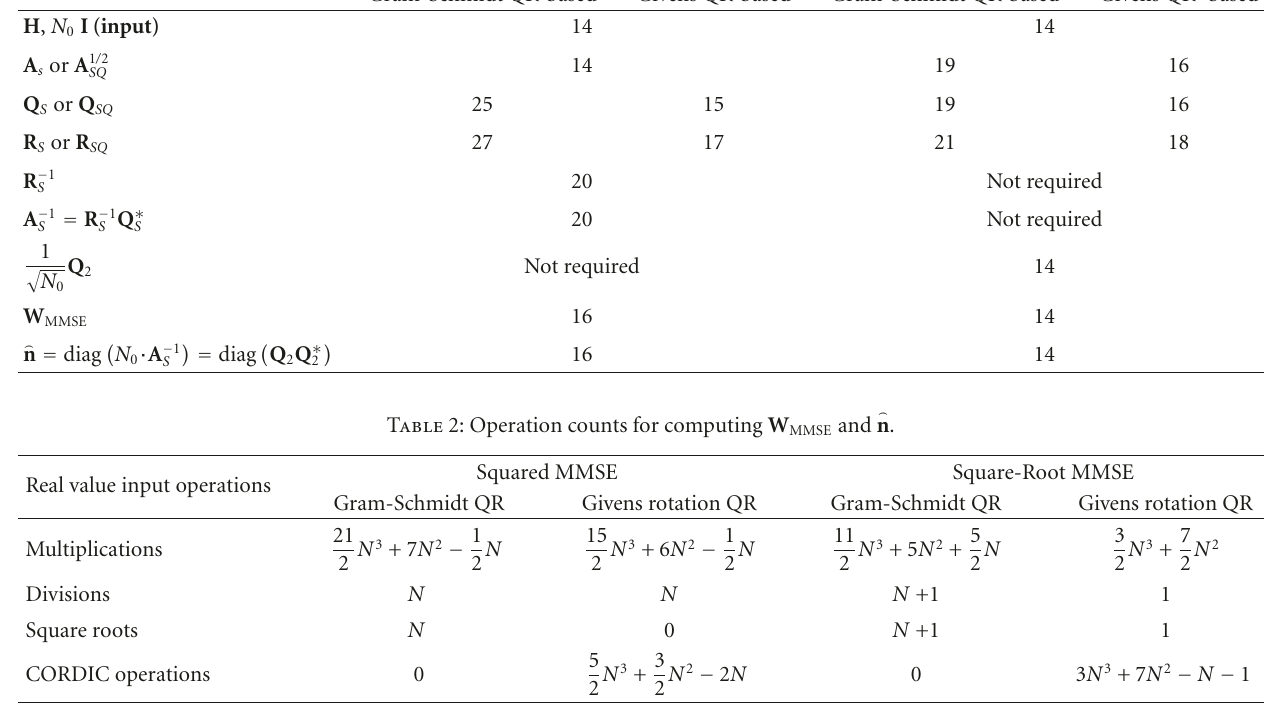
Table 1: Required bit precisions.